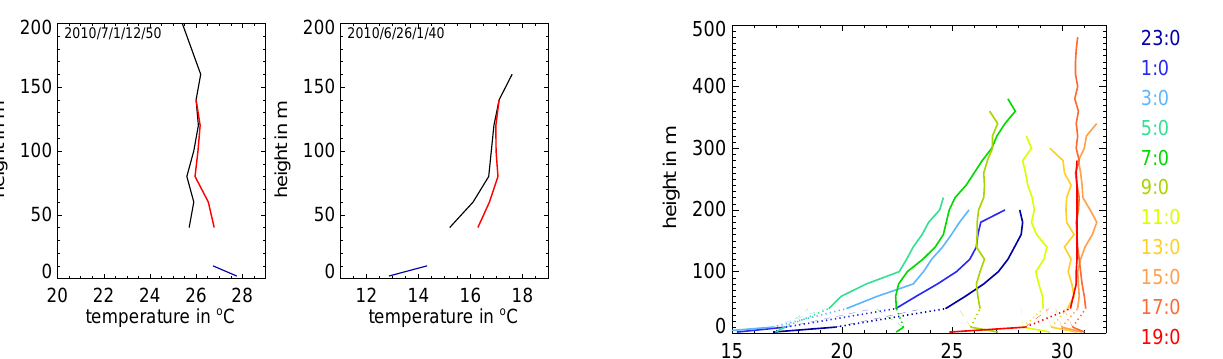
Fig. 7. Temperature profiles at Munich airport without (black) and with (red) empirical adiabatic corrections